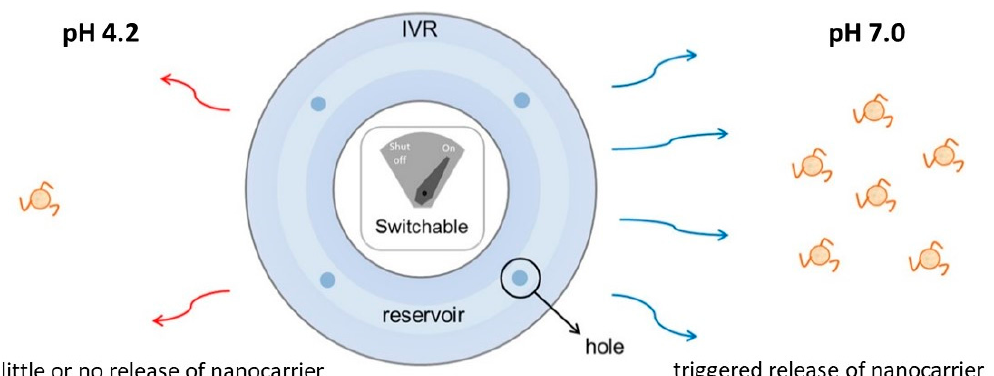
Figure 12. The reservoir of the IVR filled with pH-responsive dimethylolpropionic acid (DMPA)- loaded PU hydrogels, with drilled holes for diffusion of nanocarriers. The nanocarriers were observed to have higher release at pH 7.0 compared to pH 4.2, due to the deprotonation of COOH groups of the DMPA (Adapted and reprinted with permission from ref. [76] © 2018, American Chemical Society).